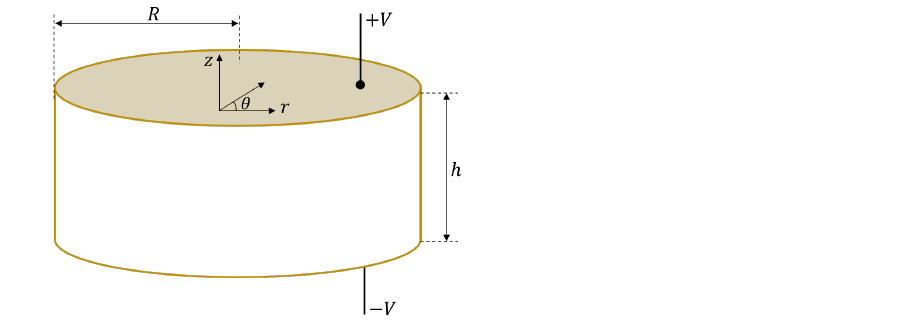
Figure 1. Piezoelectric ceramic with axial polarization, thickness h , and radio R . The coordinates ( r , θ , z ) are cylindrical coordinates with the origin in the center of the